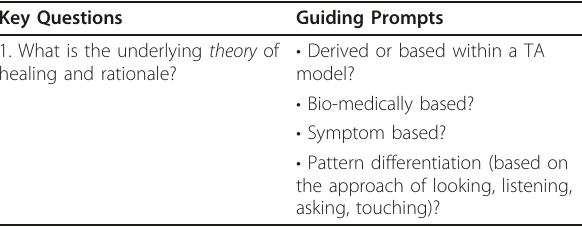
Table 3 Exploratory guide for assessing acupuncture model validity (for complex